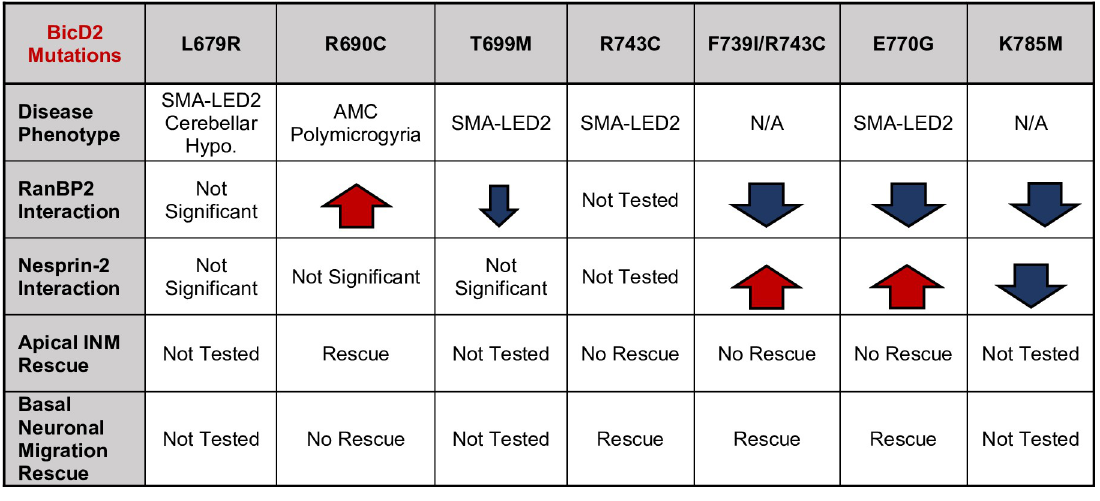
Fig 7. Summary of mutational